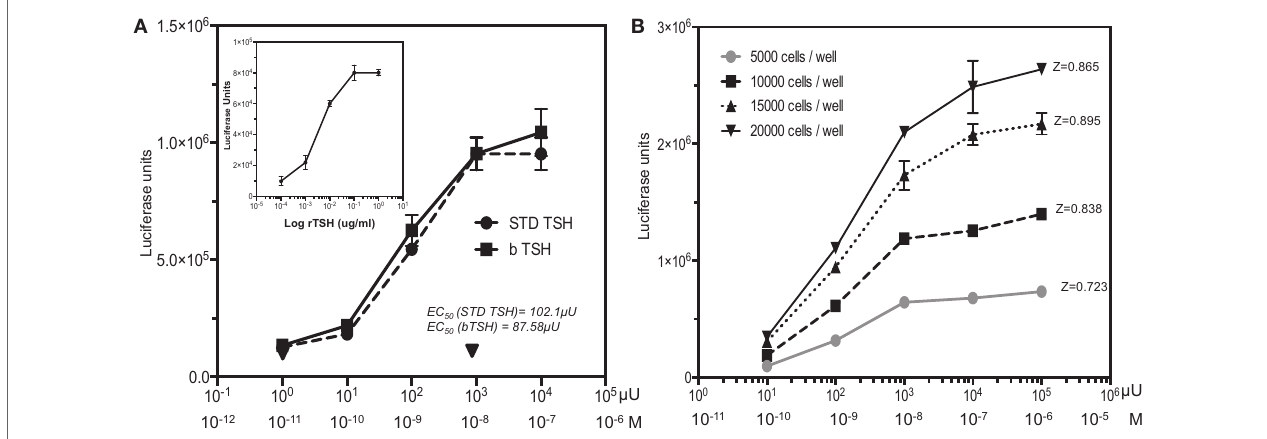
FIGURe 1 | tsh dose–response and hts optimization. (A) The TSHR-Glo cells were tested against bovine TSH and a WHO international standard human TSH (81/565 obtained from NIBSC). Inset: shows the response curve using recombinant human TSH. (B) To optimize the use of the assay as an HTS method, we performed a similar TSH dose–response using different cell densities on a proxy-shallow 384-well plate and calculated the Z factor scores under each cell density. A Z factor score of 0.895 with 15,000 cells/well was adopted as the standard format of cell density for HTS screening [note: 1 ≥ z ≥ 0.5 is considered an excellent assay (23)]. Luciferase is measured on a luminescence based microplate reader after lysis of the cells with a one-step reagent and expressed as luciferase units